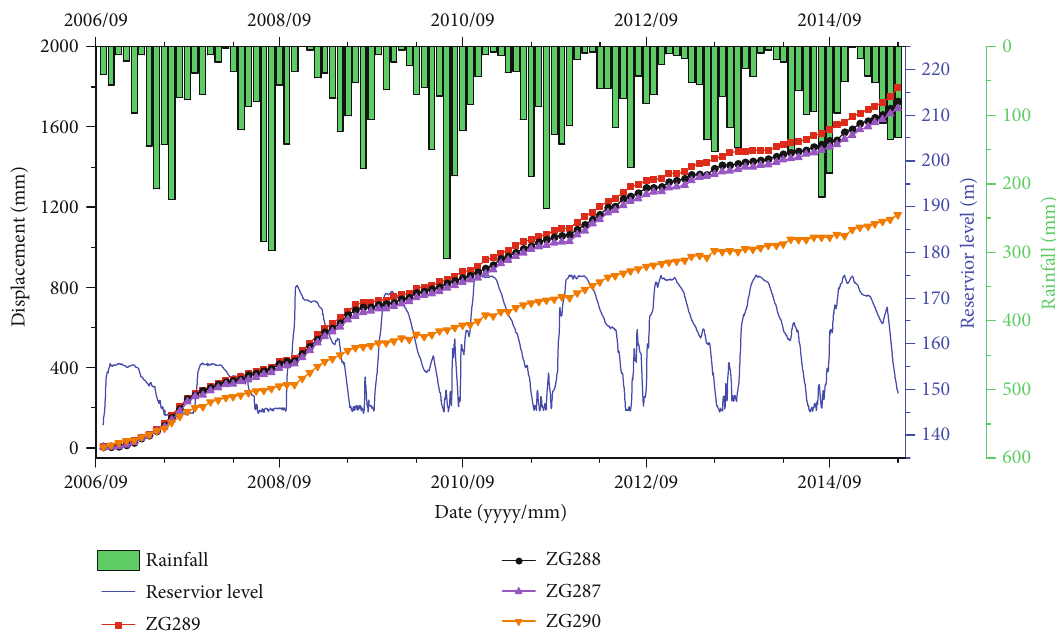
Figure 4: Time series of Tanjiahe landslide monitoring data spanning the period from October 2006 to June